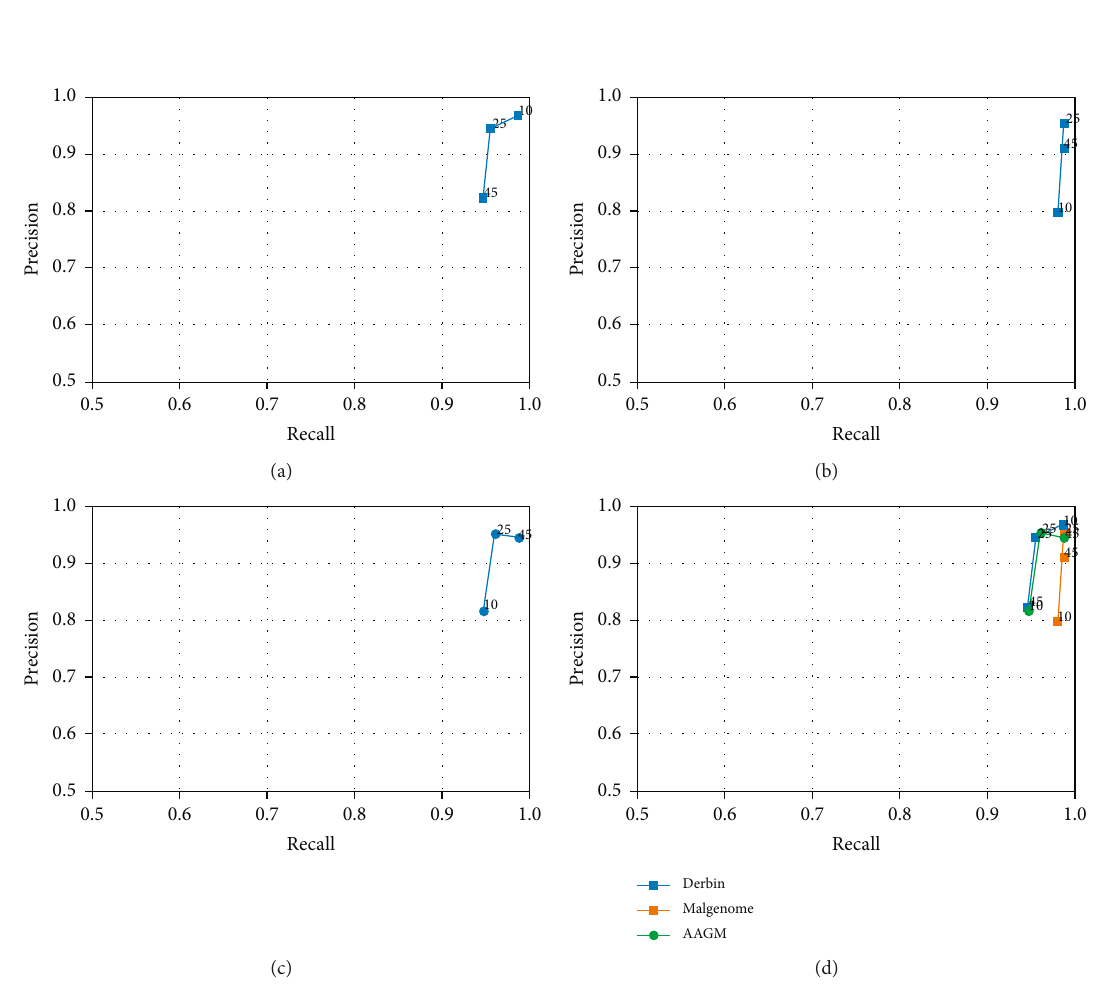
Figure 18: P-R curves for core topics quantity. (a) Drebin dataset. (b) Malgenome dataset. (c) AAGM dataset. (d) Performance